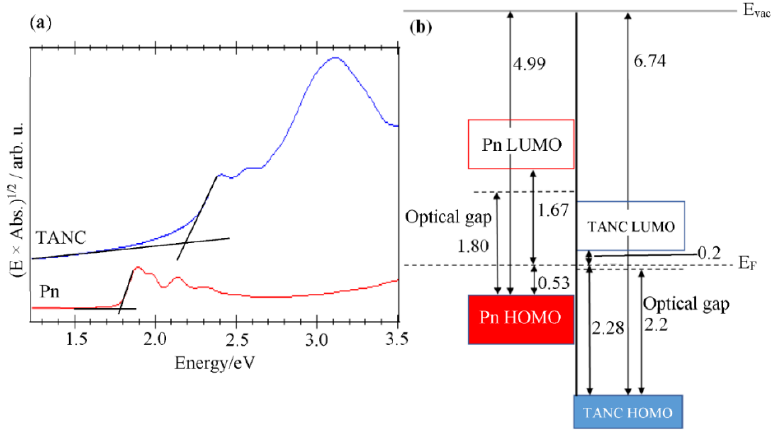
Figure 6. ( a ) UV–vis absorption spectra of the vacuum-deposited films of TANC and pentacene on quartz substrates. The vertical scale is taken in (energy × absorbance) 1/2 for the estimation of the optical band gap assuming direct gap semiconductor materials. ( b ) An energy level diagram of the heterojunction between PnSC and TANC.